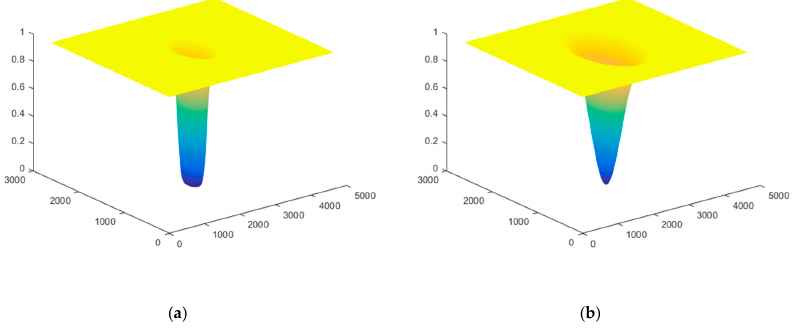
Figure 2. ( a ) Butterworth ( n = 4 , D (cid:2868) = 259 ) and ( b ) Gaussian ( σ = 259) filters for edge detection in the frequency